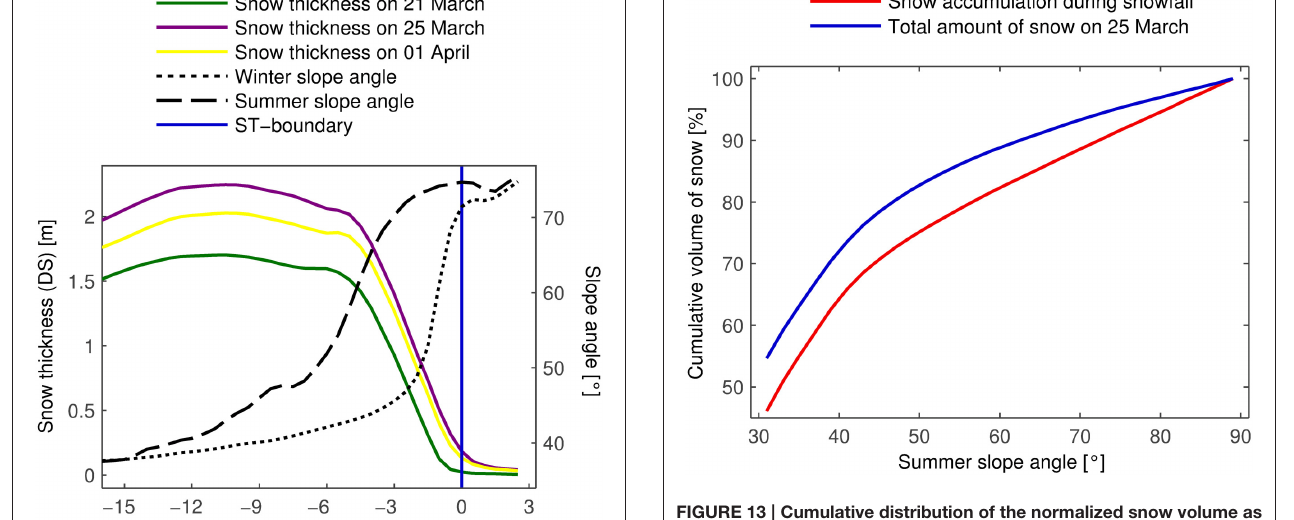
FIGURE 13 | Cumulative distribution of the normalized snow volume as a function of the summer slope angle. Calculated for slope angle classes of 2 ◦ . The complete rock face/study site is considered. More than 10% of the total amount of snow lay in areas steeper than 60 ◦